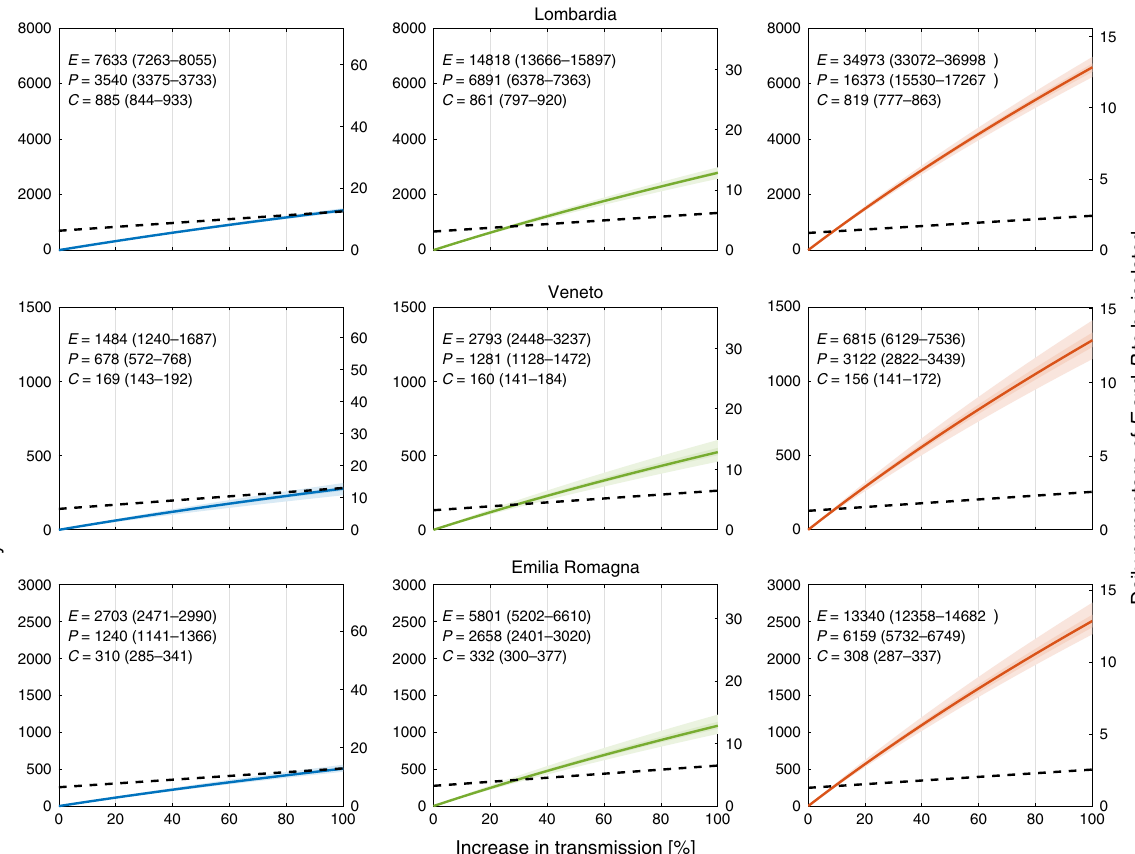
Fig. 4 Charting the isolation efforts required to control COVID-19 in Italy. Daily number (left axis) and daily percentage (right axis) of exposed E and individuals at peak infectivity, P , to be isolated daily to maintain the epidemic trajectory onto the blue curve in Fig. 2 (corresponding to the baseline scenario) despite the possible increase in transmission induced by the actual release of restrictions (horizontal axes). Different columns refer to different values of the symptomatic fraction σ : 50% (left, blue), 25% (center, green), and 10% (right, red). Solid lines refer to median values, shaded areas to the 95% (lighter shade), and 50% con fi dence intervals. In each panel, median and 95% con fi dence interval of E , P and new daily symptomatic cases ( C ) are given (estimates refer to May 4). The dashed black lines indicate the estimated number of E and P individuals that can be isolated by tracing all the infections generated by the new daily symptomatic cases. The other Italian regions are shown in Supplementary Figs. 4, 5, and